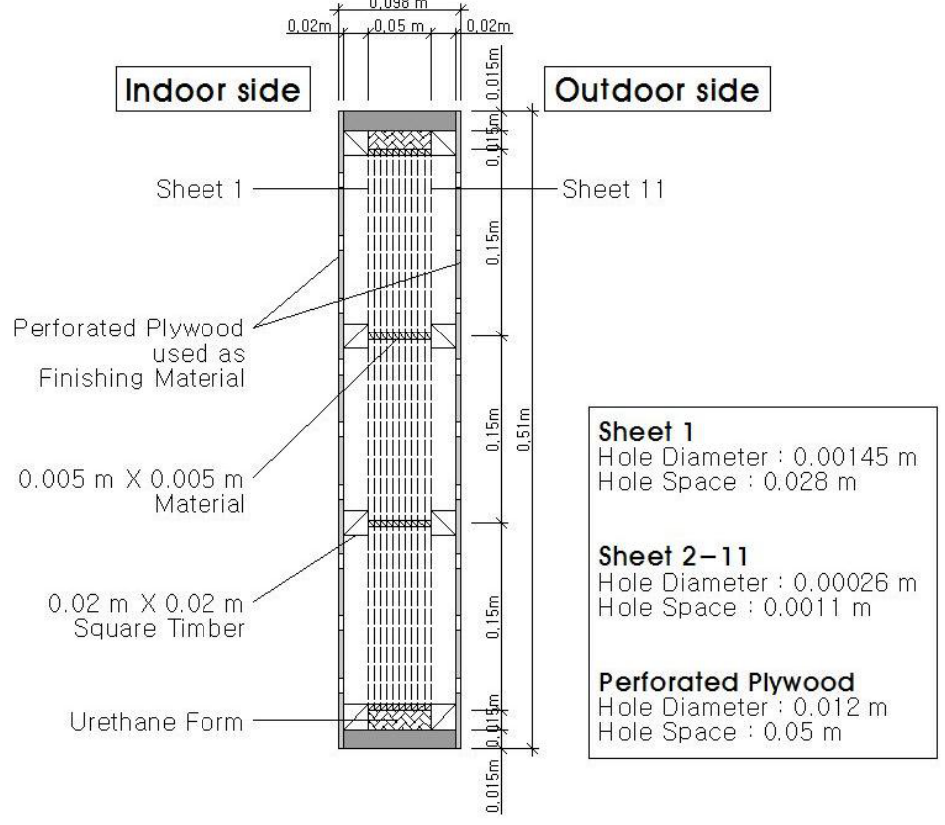
Figure 3. BAM test sample.